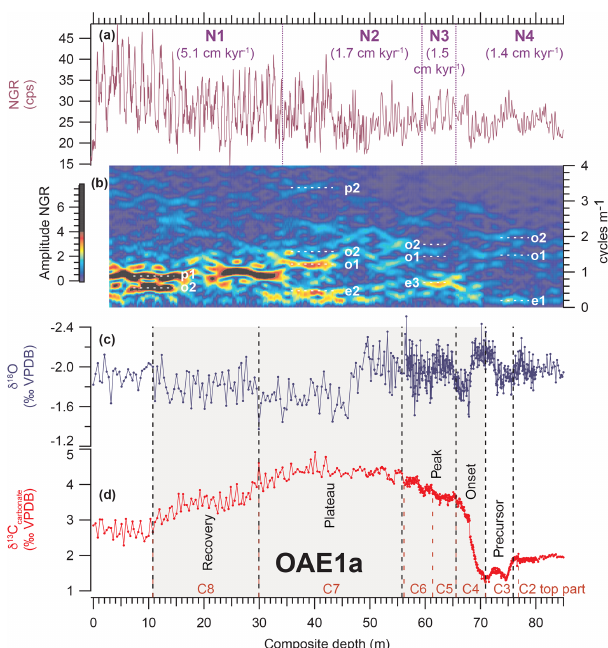
Figure 5. Identification of orbital periodicities over OAE2 from evolutive harmonic analysis (EHA) of natural gamma ray (NGR) data in Tarfaya Basin Core SN ◦ 4. (a) NGR. (b) EHA plot of NGR; orbital periodicities are indicated by white dashed lines: eccentricity e2 (127kyr) and e3 (97kyr), obliquity o1 (48kyr) and o2 (38kyr), precession p1 (22kyr) and p2 (18kyr) (Table S5.3). (c) δ 18 O and (d) δ 13 C org from Kuhnt et al. (2017) and Beil et al. (2018); a–c indicate prominent maxima following Voigt et al.